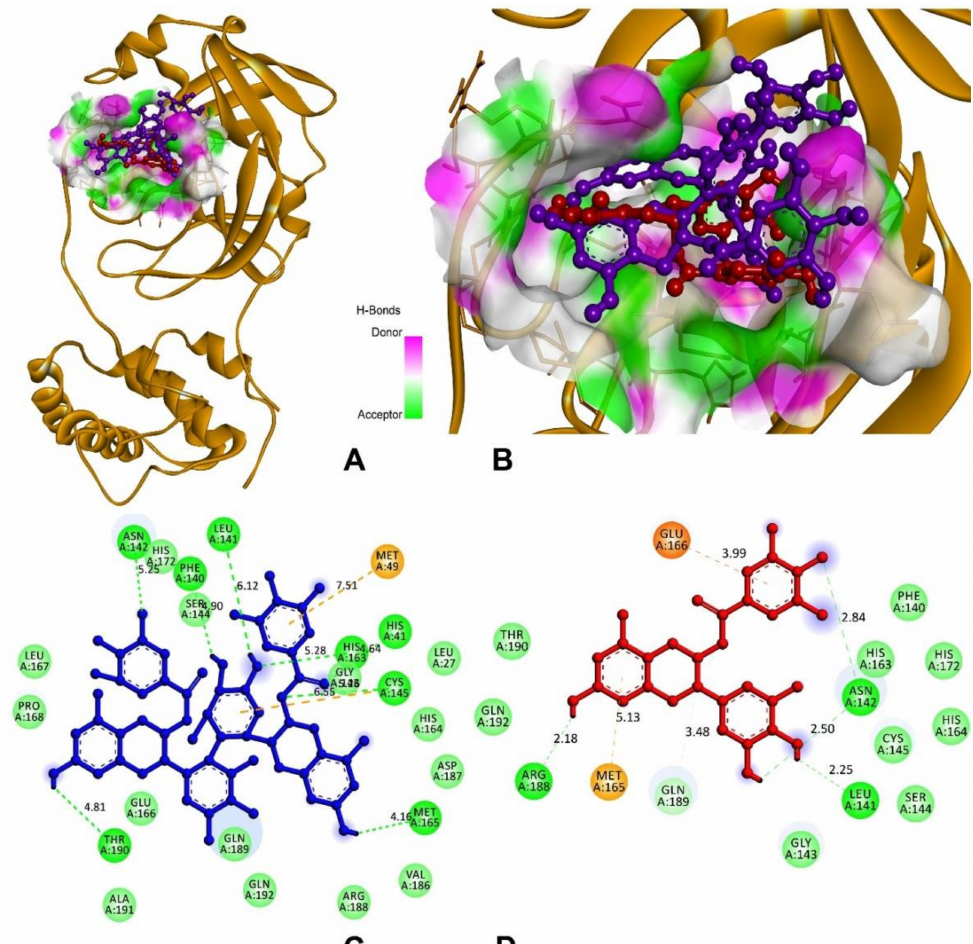
Figure 11. Molecular docking and interactions of M pro with theasinensin A and epigallocatechin gallate. ( A ) M pro ( yellow ) bound with compounds of theasinensin A ( blue ) and epigallocatechin ( red ). ( B ) Higher magnification of theasinensin A ( blue ) and epigallocatechin gallate ( red ) with M pro . ( C ) Molecular interactions of M pro and theasinensin A ( blue ). ( D ) Molecular interactions of M pro and epigallocatechin ( red